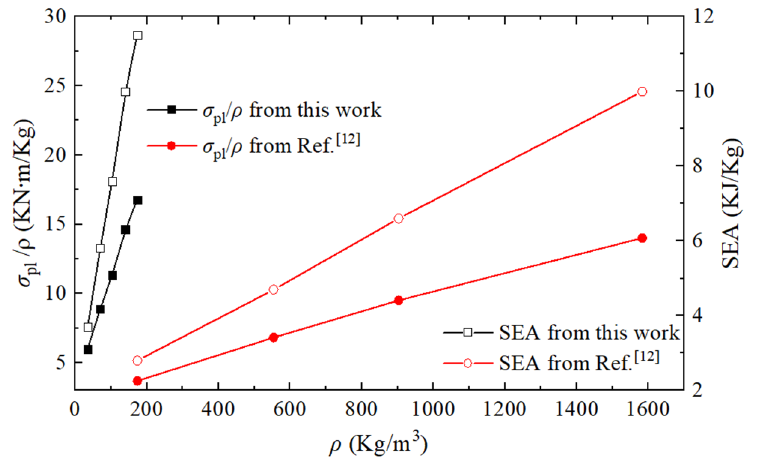
Figure 14. Comparison of σ pl / ρ and SEA of the PHSS in this work with the MHSS in Reference [12].